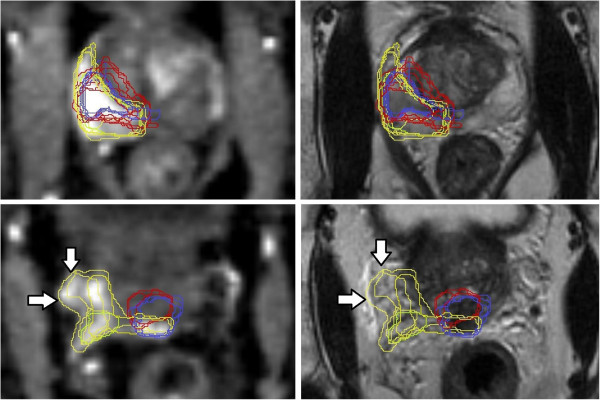
(Patient No. 4). Transversal slices in the middle third (above) and near the prostate base (below) of the prostate gland; above/below left = DCE-, above/below right = T2w-sequence. Above left and right: DCE based GTV-delineation (yellow contours) with high KI. Below left: two observers erroneously delineated laterally adjacent enhancing periprostatic vascular structures near the prostate base (arrows indicating yellow contours). Below right: arrows indicate presence of periprostatic vessels.